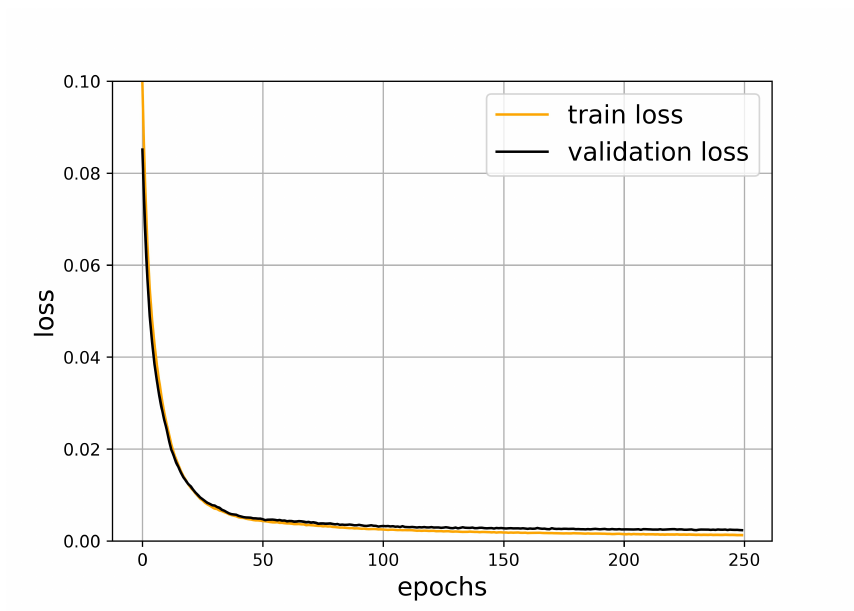
Figure 6. The train and validation loss in the function of epochs.